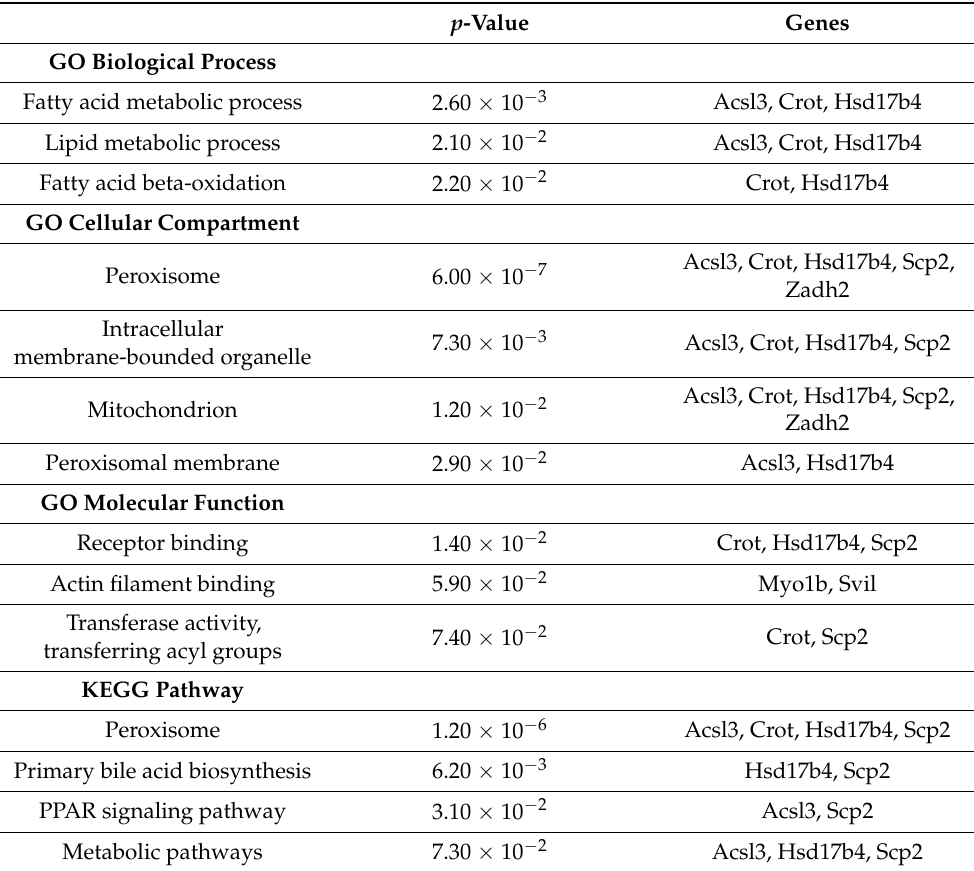
Table 2. Gene Ontology and KEGG pathway analysis of upregulated proteins in Hacl1 − / − mouse